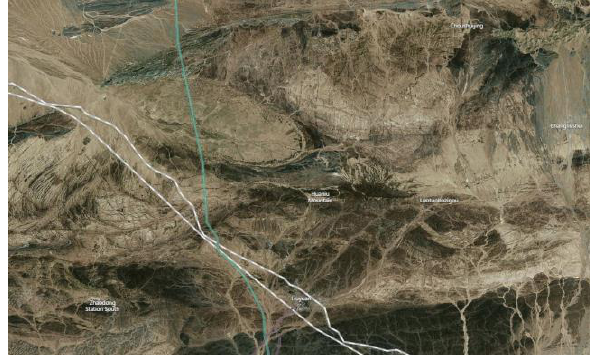
Figure 2. The map of the study area (©2018 Bing Maps)